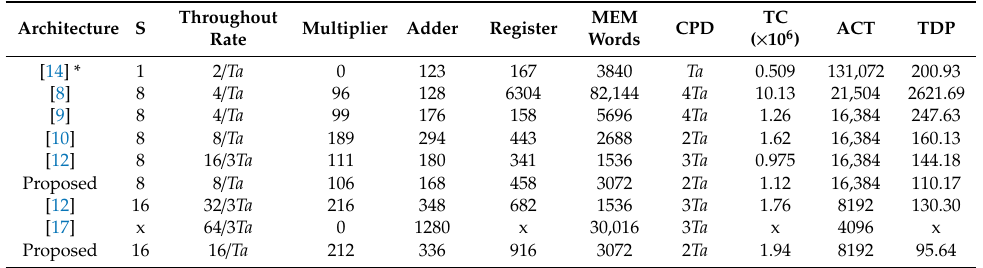
Table 2. Hardware estimation and performance comparison of 3-level 2-D architecture for 9 / 7 filter with 512 × 512 image